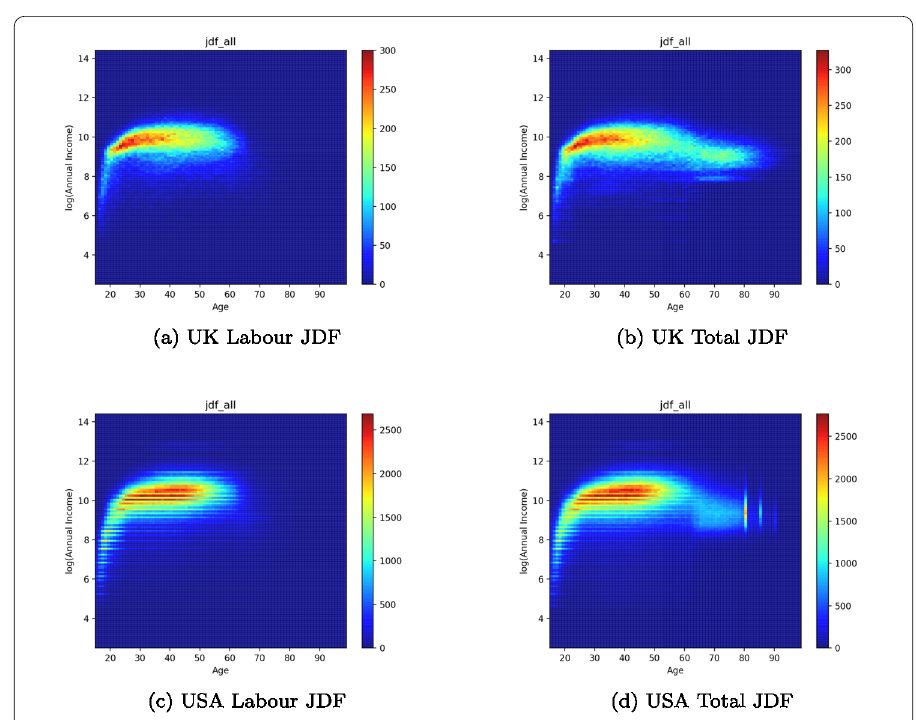
Figure 1 All Years Pooled Age and Income Joint Distribution Function for UK and USA between Ages 15–100 where labour and total income heatmap reflect unique shape. Income after retirement can be observed on Total Income JDFs which include pension and capital income, the data from USA is top-coded which is reflected by stripes of concentrated concentration around ages 80, 85 and